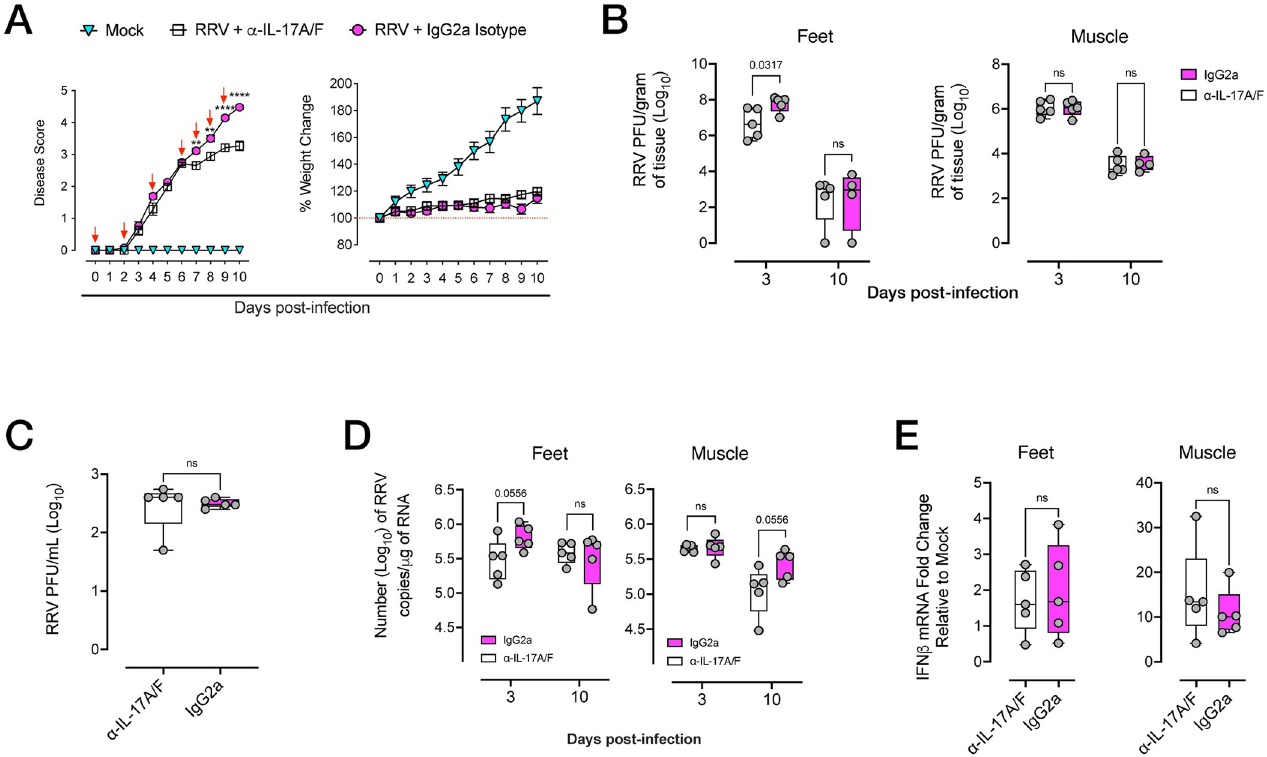
Fig 6. Modulation of IL-17 signaling ameliorates RRV disease. A) Disease and weight loss kinetics of RRV-infected C57BL/6J mice treated with anti-IL-17A/ F monoclonal antibody (mAb; 2.86mg/kg) or with IgG2a isotype from 0, 2, 4 dpi and daily from 6 dpi to 9 dpi (red arrows show daily treatment). Data shown as mean +/- SEM. Statistically significant differences between groups determined by multiple t -test with Holm-Sidak correction. �� , p < 0.01; ���� , p < 0.0001. B) RRV T 48 viral titers in the feet and quadriceps muscle of RRV-infected C57BL/6J mice treated with anti-IL-17A/F mAb or with IgG2a isotype, at 3 and 10 dpi. Tissue viral titers were normalised to tissue weight and expressed as PFU/per gram of tissue (PFU/g). C) RRV T 48 viral titers in the serum of RRV-infected C57BL/6J mice treated with anti-IL-17A/F mAb or with IgG2a isotype at 3 dpi. D ) RRV RNA load in the feet and quadriceps muscle of RRV-infected C57BL/6J mice treated with IL-17A/F mAb or with IgG2a isotype, at 3 and 10 dpi. Data represented as RRV RNA copy number (log 10 / μ g of RNA). E) Fold change in IFN β mRNA expression in the feet and muscle of RRV-infected C57BL/6J mice treated with IL-17A/F mAb or with IgG2a isotype, at 3 dpi. Data shown as fold change in expression compared to mock-infected mice, normalized to housekeeping gene expression. Data shown (mean +/- SEM) is representative of 3 independent experiments (n = 6 mice per group). Statistically significant differences between groups determined by Mann-Whitney U Test, p values indicated on graphs. Statistically significant differences shown as numerical p values (p < 0.05). ns: not